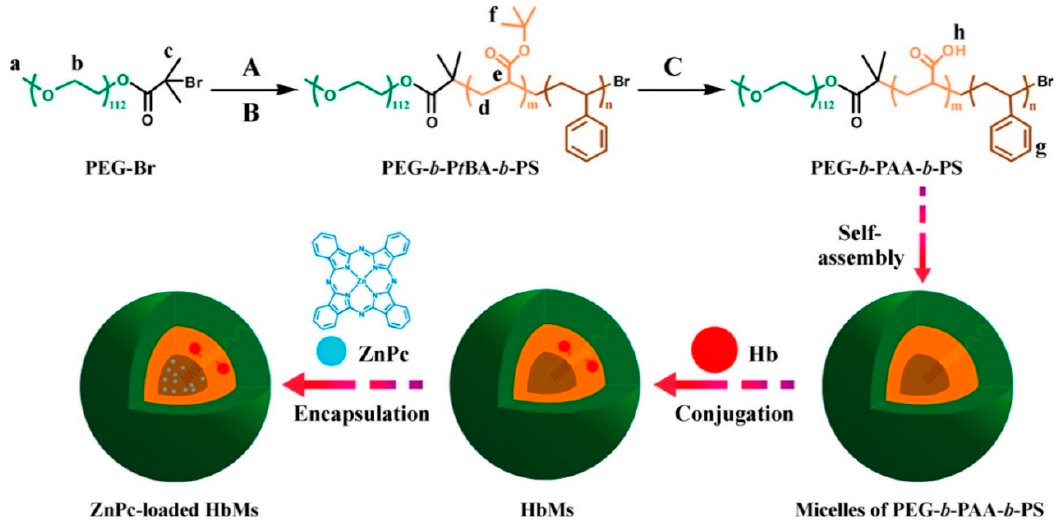
Figure 5. Synthesis of ZnPc-loaded hemoglobin conjugated micelles (HbMs): ( A ) tert -butyl acrylate ( t BA), copper(I) bromide (CuBr), N , N , N (cid:48) , N ”, N ”-pentamethyl diethylene triamine (PMDETA), 50 ◦ C; ( B ) styrene, CuBr, PMDETA, chlorobenzene, 110 ◦ C; ( C ) trifluoroacetic acid, chloroform, 25 ◦ C. PEG: poly(ethylene glycol); P t BA: poly( tert -butyl acrylate); PS: polystyrene; PAA: poly(acrylic acid); Hb: hemoglobin; HbMs: hemoglobin-conjugated micelles; ZnPc: zinc phthalocyanine. Reproduced with permission from Wang, S.; Yuan, F.; Chen, K.; Chen, G.; Tu, K.; Wang, H.; Wang, L. Synthesis of hemoglobin conjugated polymeric micelle: A ZnPc carrier with oxygen self-compensating ability for